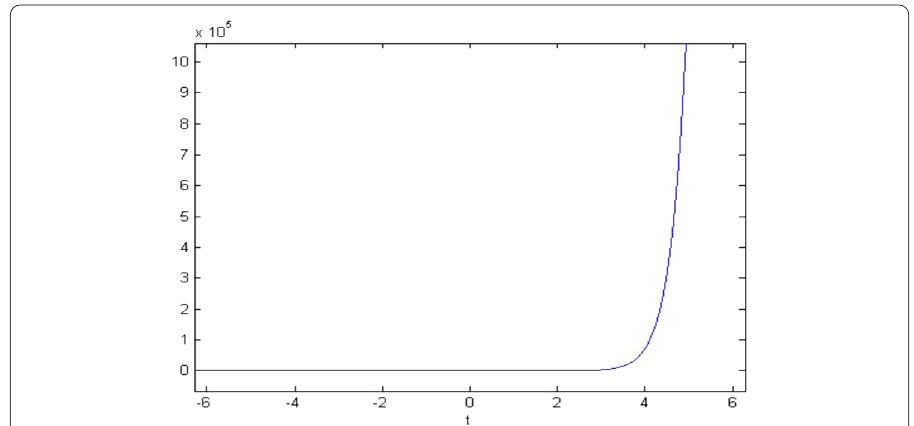
Figure 1 Solution of Bagley–Torvik equation f ( t ) = 1, ν = 1/2